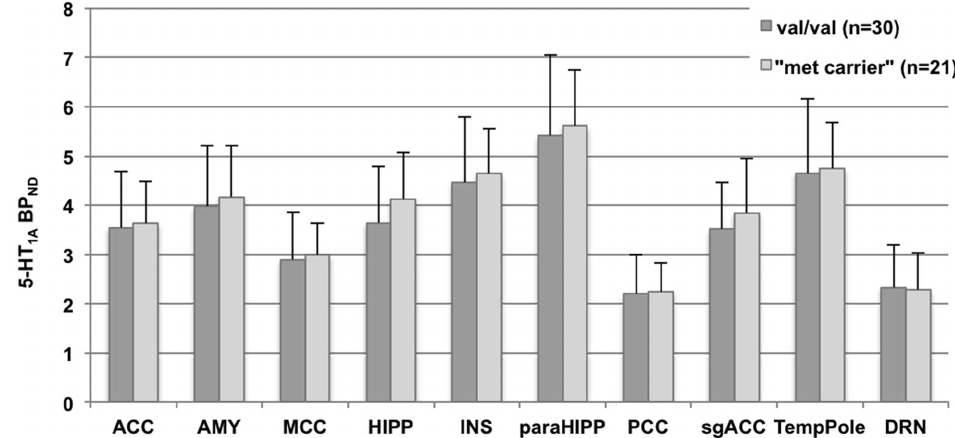
Figure 1. Bar chart plotting serotonin-1A binding potential (5-HT 1A BP ND ) according to BNDF Val66Met genotype status. Values at the y-axis represent 5-HT 1A BP ND separated for val/val and met-carrier, respectively, x-axis shows regions of interest. Regions and values correspond to table 2. ACC: anterior cingulate cortex, AMY: amygdala, MCC: medial cingulate cortex, HIPP: hippocampus, INS: insula, paraHIPP: parahippocampus, PCC: posterior cingulate cortex, TempPole: temporal pole, DRN: dorsal raphe nucleus.